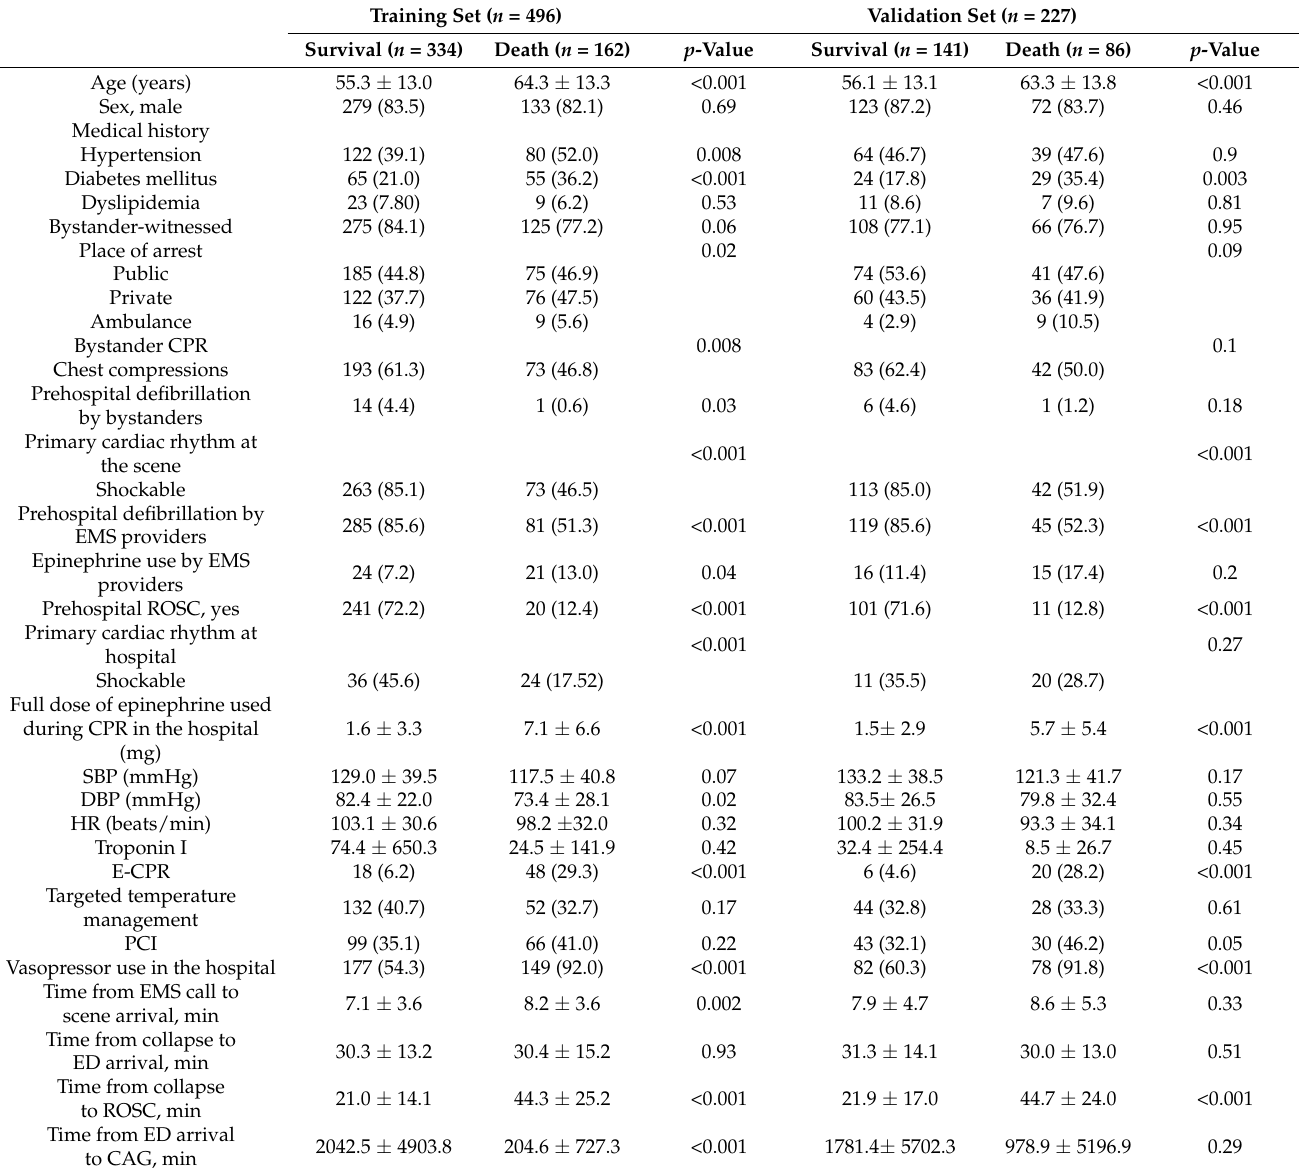
Table 1. Patient demographics and clinical characteristics according to survival outcome at